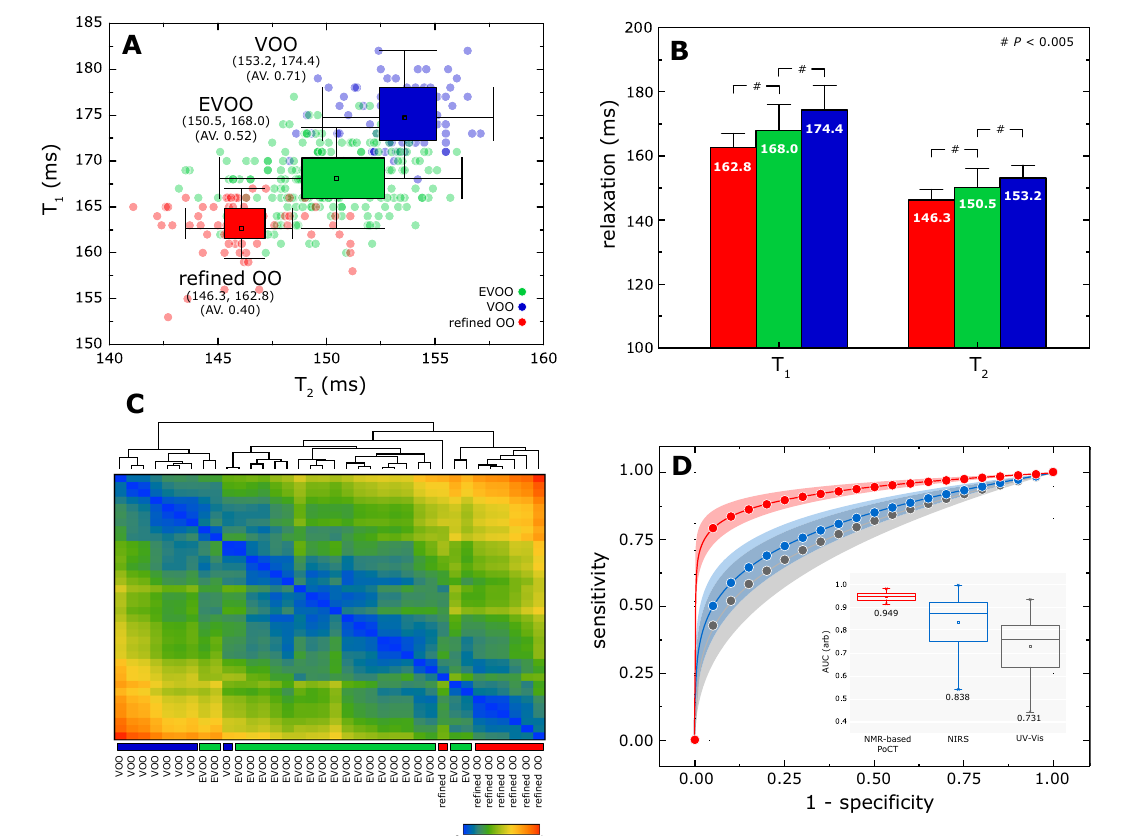
Fig. 2 Rapid identi fi cation and characterization of olive oil using NMR-based traits. A Two-dimensional mapping of EVOOs (green), VOOs (blue), and re fi ned OO (red) in the T 1 -T 2 magnetic phase diagram. A wide variety of Olive oils (i.e. 21 EVOOs, 8 VOOs, and 7 re fi ned OOs) commercially available from different manufacturers were purchased off-the-shelf in Braga, Portugal or otherwise through online platforms. Each data point represents one sampling with a total 360 samplings collected. The mean T 1 and T 2 values and acid value were denoted below. B Average T 1 and T 2 relaxation times (ms) for the different types of OOs. The statistical analysis of the data was calculated using unpaired two- tailed Student t -tests ( P < 0.005) (details in Supplementary Fig. 1). C Rapid classi fi cation of OOs using the NMR-based traits in the form of clustering analysis. This hierarchical clustering was constructed based on the Euclidean distance between the averaged measures per sample (details in Supplementary Table 1). Their quantitative linkages (e.g. inter- and intra-cluster similarity) are shown as a heatmap. D The ROC curves for NMR-based traits (red), NIRS (blue), and UV-Vis (grey) calculated from a number of supervised models (details in Supplementary Fig. 2). The error zone were 99% of the con fi dence